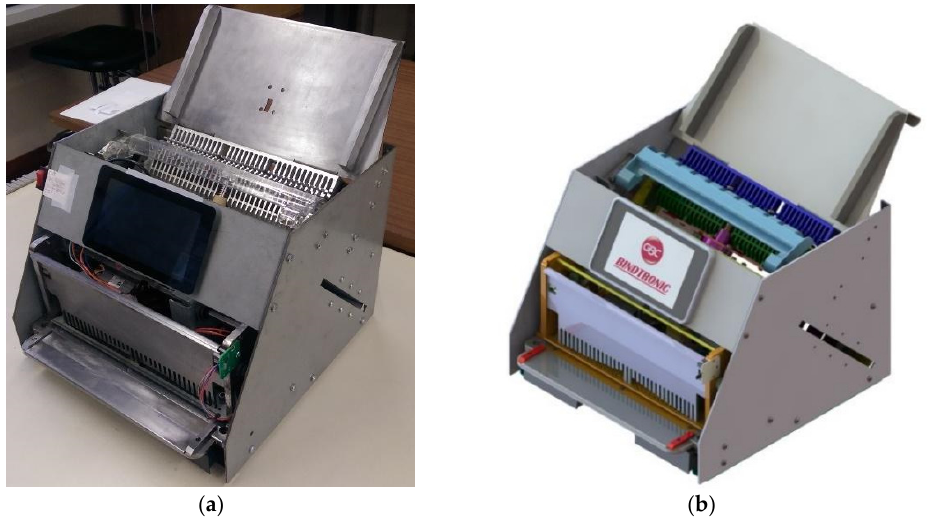
Figure 1. BindTronic prototype: ( a ) prototype; ( b ) 3D CAD model.